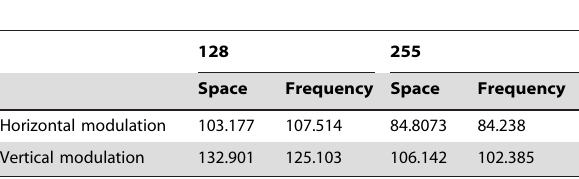
Table 4. Estimated Gaussian scale parameters for the CRT